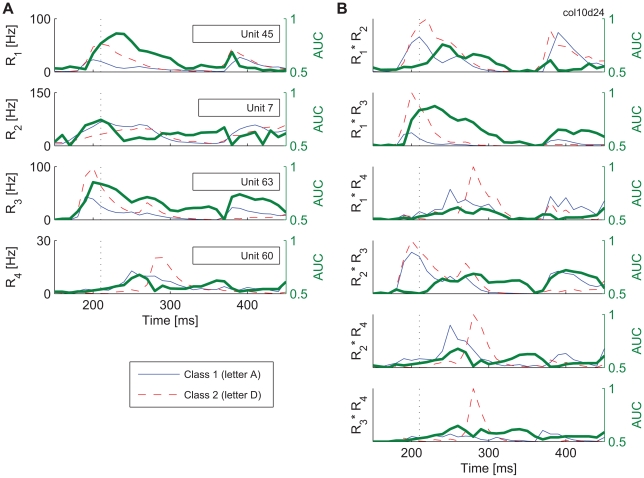
Information contents of neuronal firing rates and their second-order correlations.(A) Left y-axis: the average firing rates (Mfrs) in response to two different stimuli for the four most informative units in the analysis of time invariant classification with int = 150–450 ms, cat 1. Right y-axis: area under receiver-operating characteristic (AUC), related to the probability of correct classification. (B) Pairwise correlations in rate responses, expressed as a product between Mfrs in (A) and the corresponding AUC values obtained from these products.